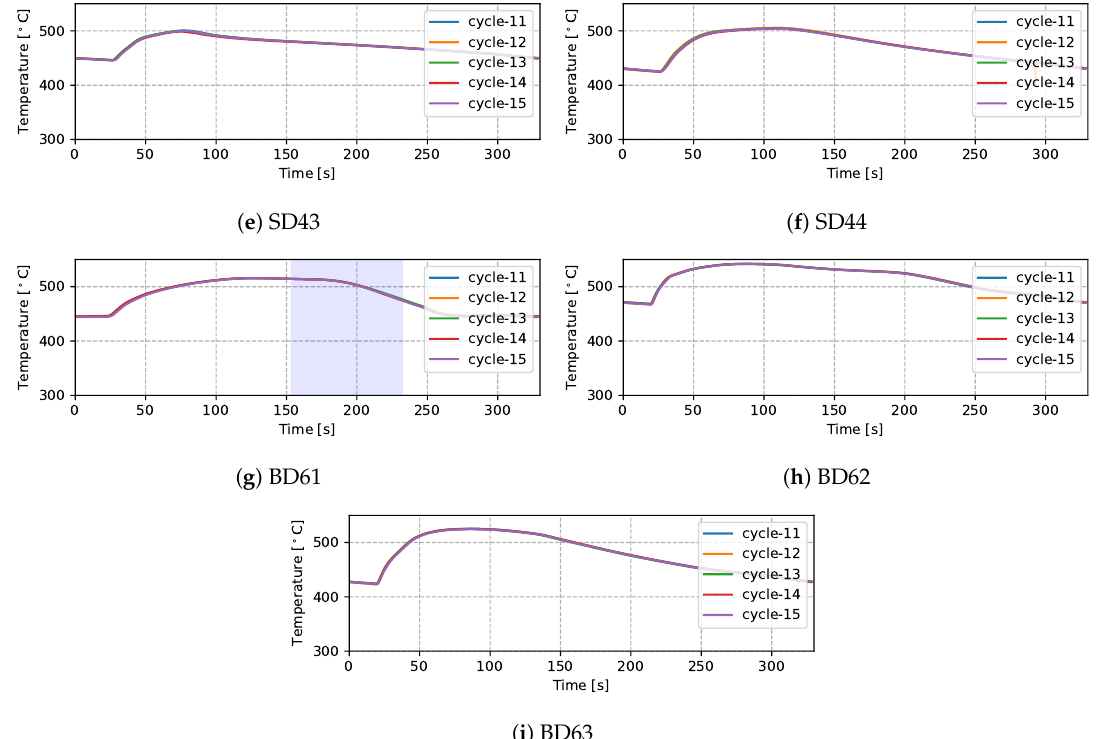
Figure 5. Measured temperatures from different locations (five cycles)—production process condition.